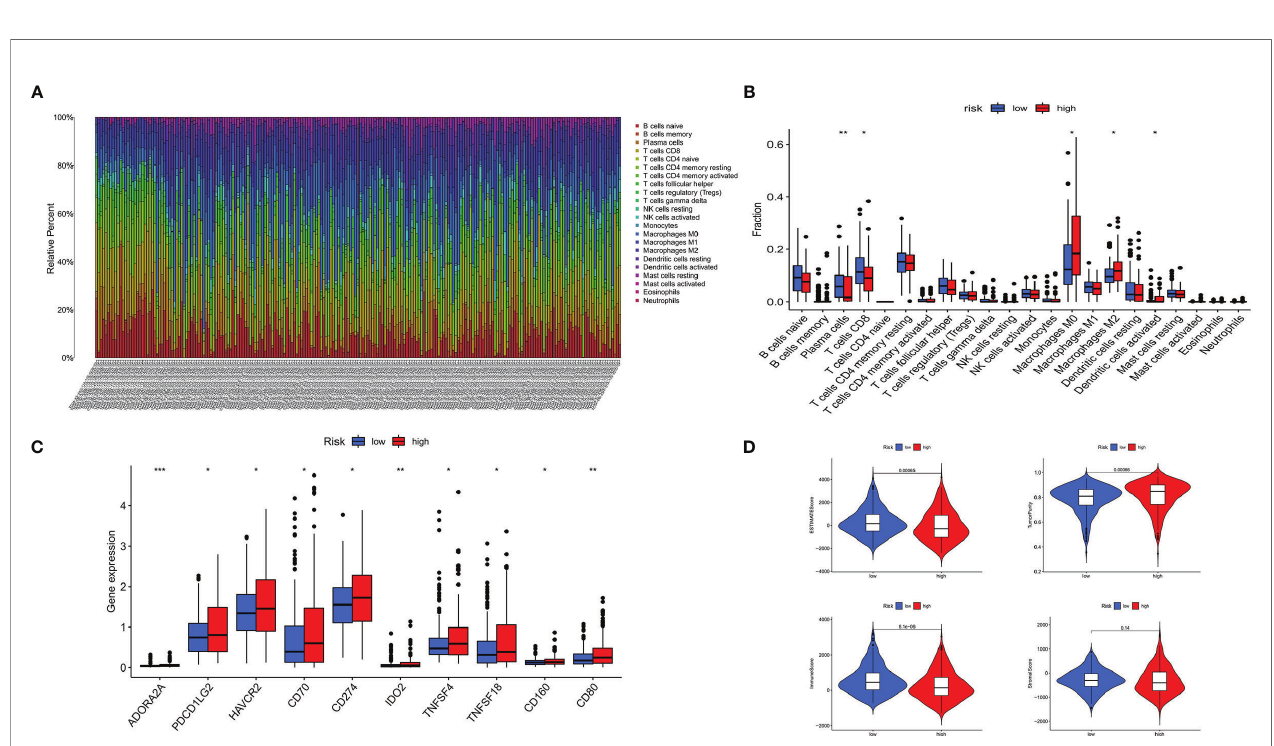
FIGURE 6 | The nomograph, based on clinical data and risk score, was created to predict the 1-, 2-, and 3-year survival rate of THCA patients.